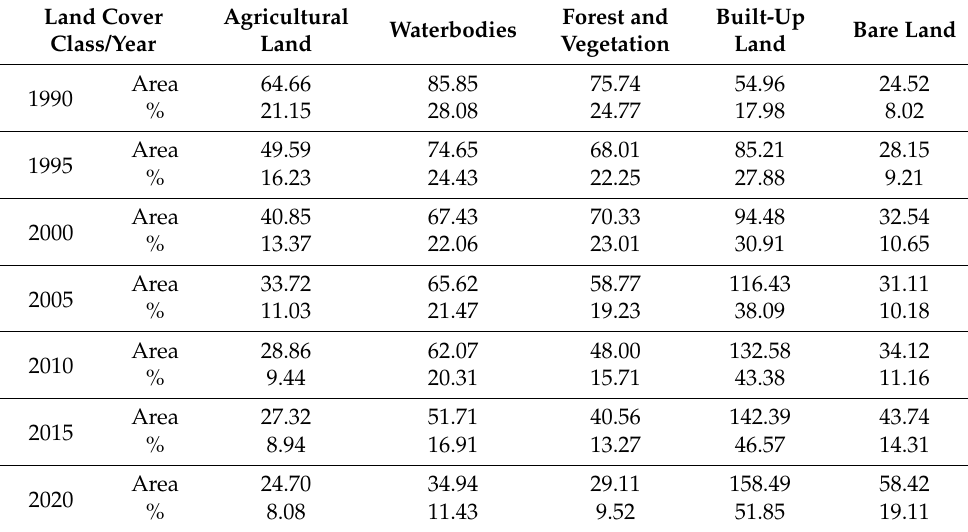
Table 4. Area and proportion of different LULC types.